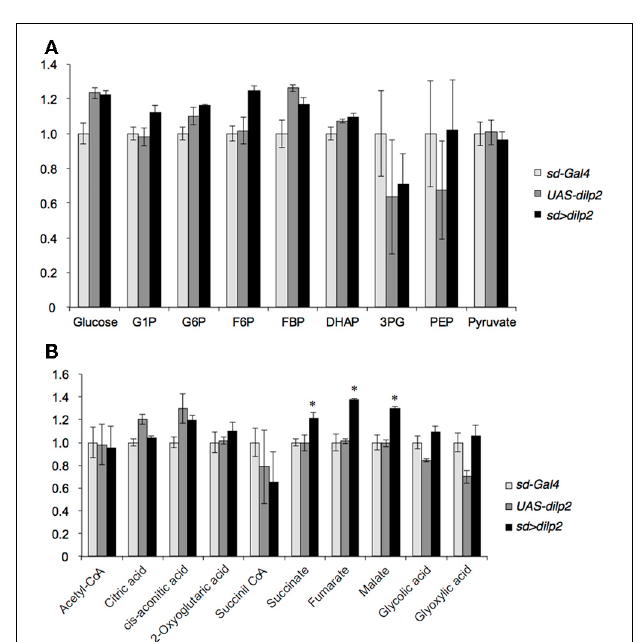
FIGURE 3 | Genetic manipulation of InR/Akt1/PI3K modifies the dilp2 -induced lethality. Relative viability of the sd > dilp2 flies was determined in combination with loss of function mutations in InR , Akt1 , or PI3K, which are components of the insulin/IGF signaling pathway. dilp2 - induced semi-lethality was markedly improved by reduction of InR or Akt1 , but enhanced by reduction of PTEN (A) . Relative viability of the sd > dilp2 flies in combination with loss-of-function mutations in Tor and S6K (B) . The Tor/S6K pathway may not contribute to mediating the semi- lethality of dilp2 -overexpressing flies. Student t -test was performed to analyze statistical significance. ∗ p < 0 . 05, ∗∗ p < 0 . 01.